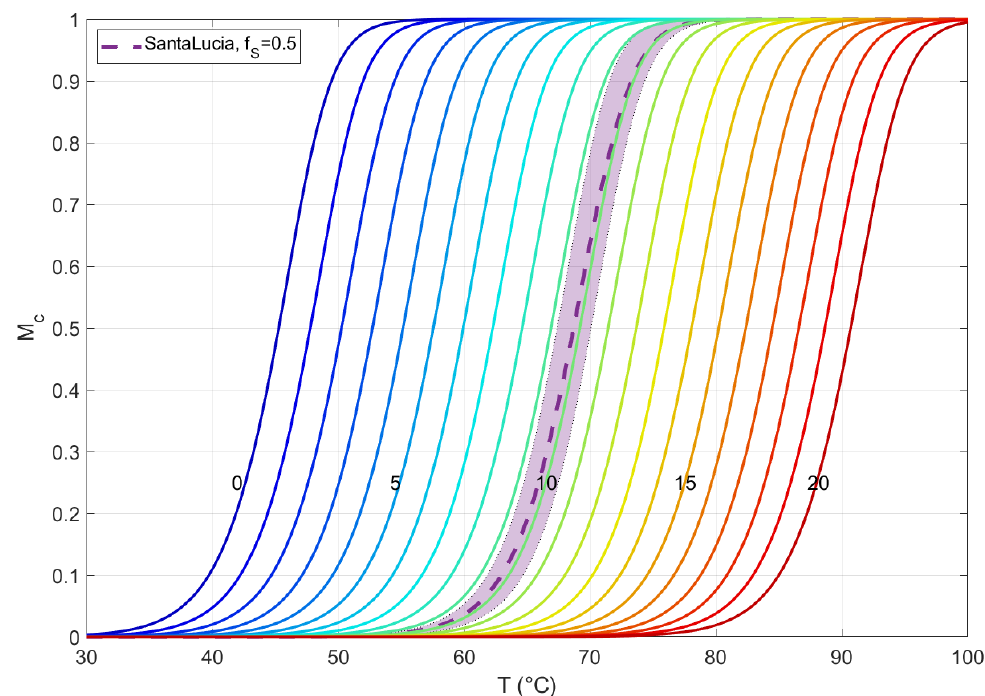
Figure A1. Melting curves of solutions of two 20 mers with perfect complementarity, computed with the analytical expression of a complementary system with two equipopulated species [11], with different pairing energies. The colored lines are computed with our averaged thermodynamic parameters, with number of C or G bases ranging from 0 to 20. Melting curves of 40 different duplexes with f S = 0.5 have been computed with the energetic parameters obtained with the standard NN protocol for each duplex; the average of these melting curves and the standard deviation are represented in the purple dashed line and shadow, respectively. All the solutions are in the same experimental conditions: c DNA = 100 nM and [ Na + ] = 1